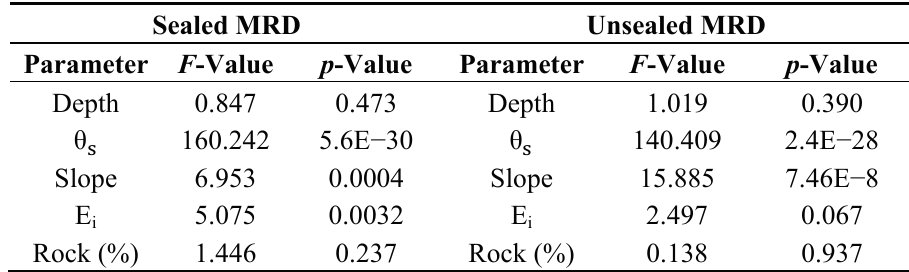
Table 2. F values and their significance, testing for differences in mean MRD values for different groups.